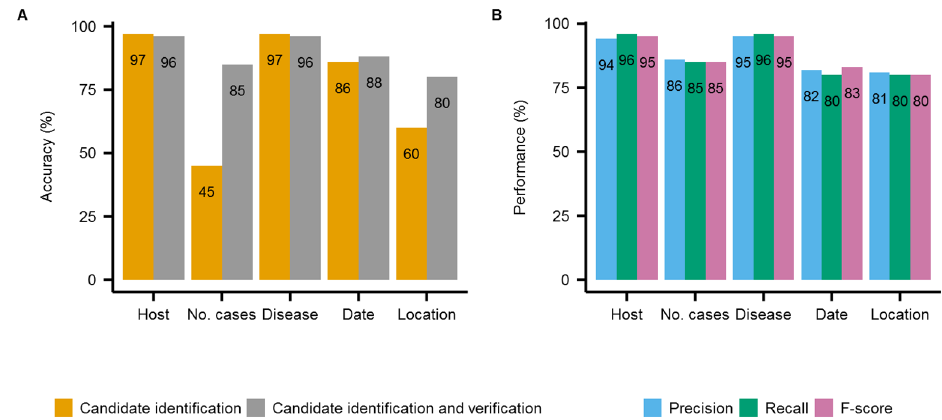
Fig 2. Accuracy of information extraction on a labelled dataset of 352 news reports. A. Comparison of the accuracy (in percentage) of candidate identification alone and of the combined candidate identification/verification based method. B. Precision, recall and F-score (in percentage) of the combined candidate identification/verification based method.